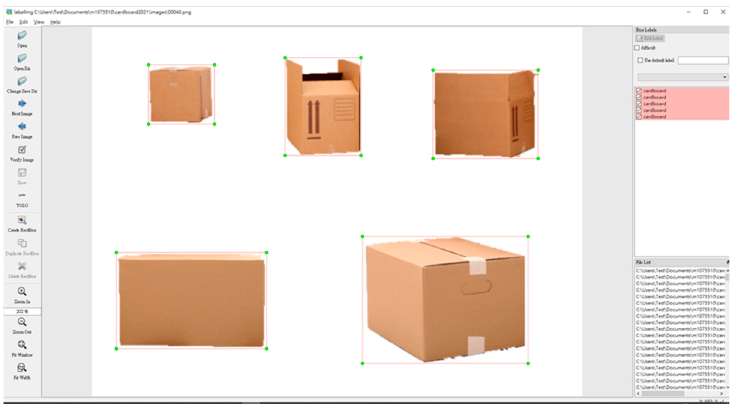
Figure 9. Labeling of obstacles.